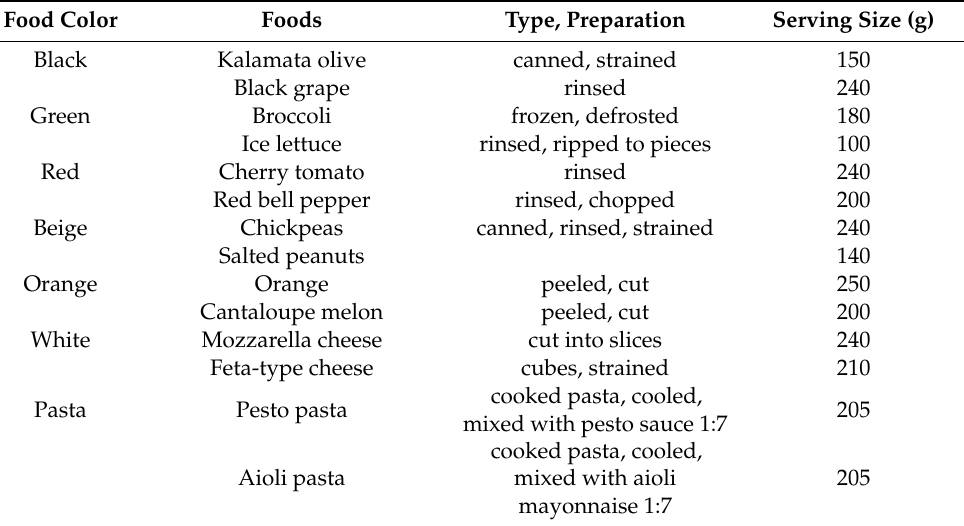
Table 1. Foods served and serving size.